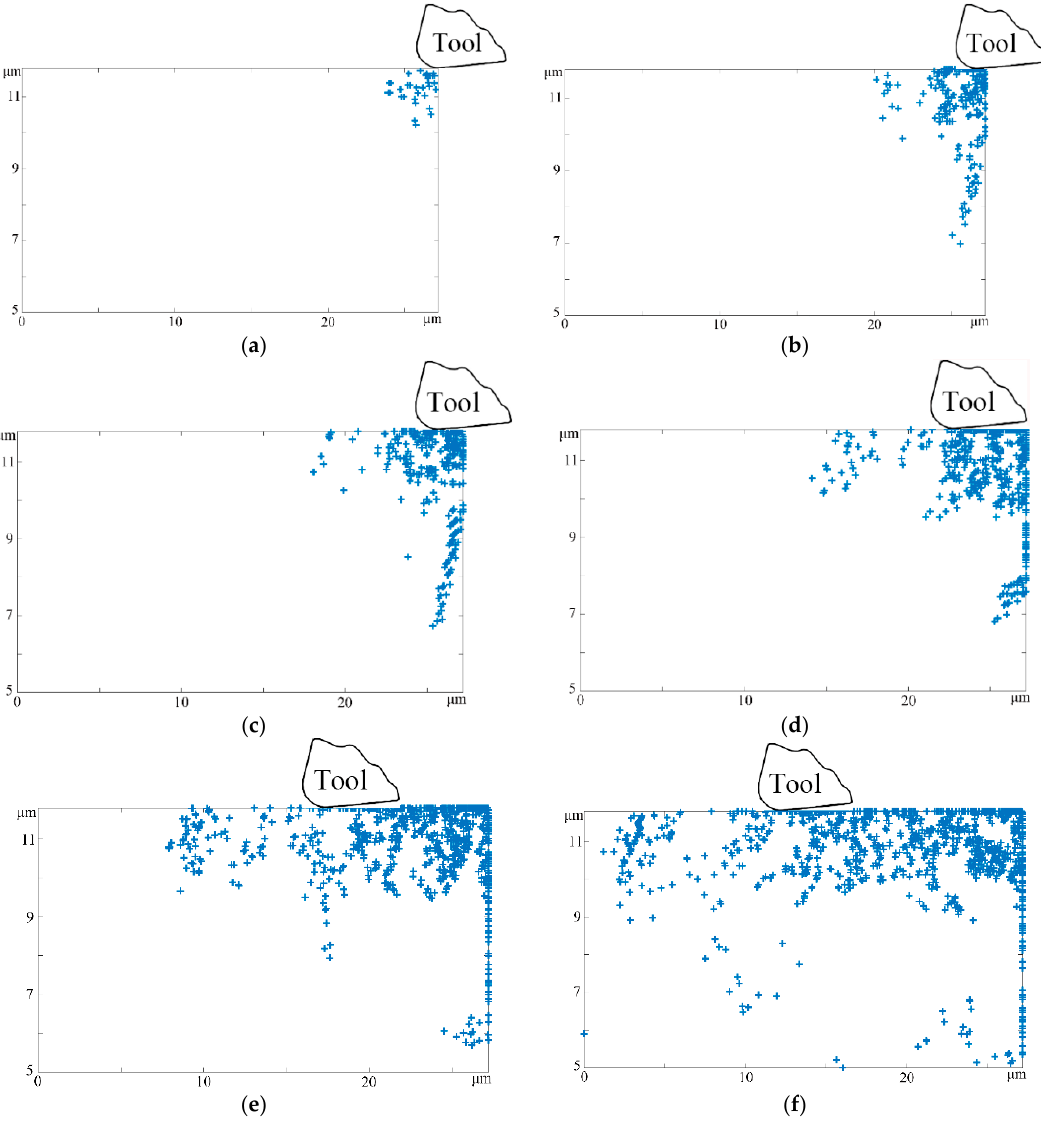
Figure 2. The subsurface defects microstructural evolution with different cut distances (cutting speed 10 m/s, cutting depth 1 μ m, tool edge radius 0.25 μ m, rake angle 5°, and clearance angle 15°). ( a ) cutting distance 0.5 μ m; ( b ) cutting distance 1.5 μ m; ( c ) cutting distance 2.5 μ m; ( d ) cutting distance 5 μ m; ( e ) cutting distance 10 μ m; ( f ) cutting distance 15 μ m.